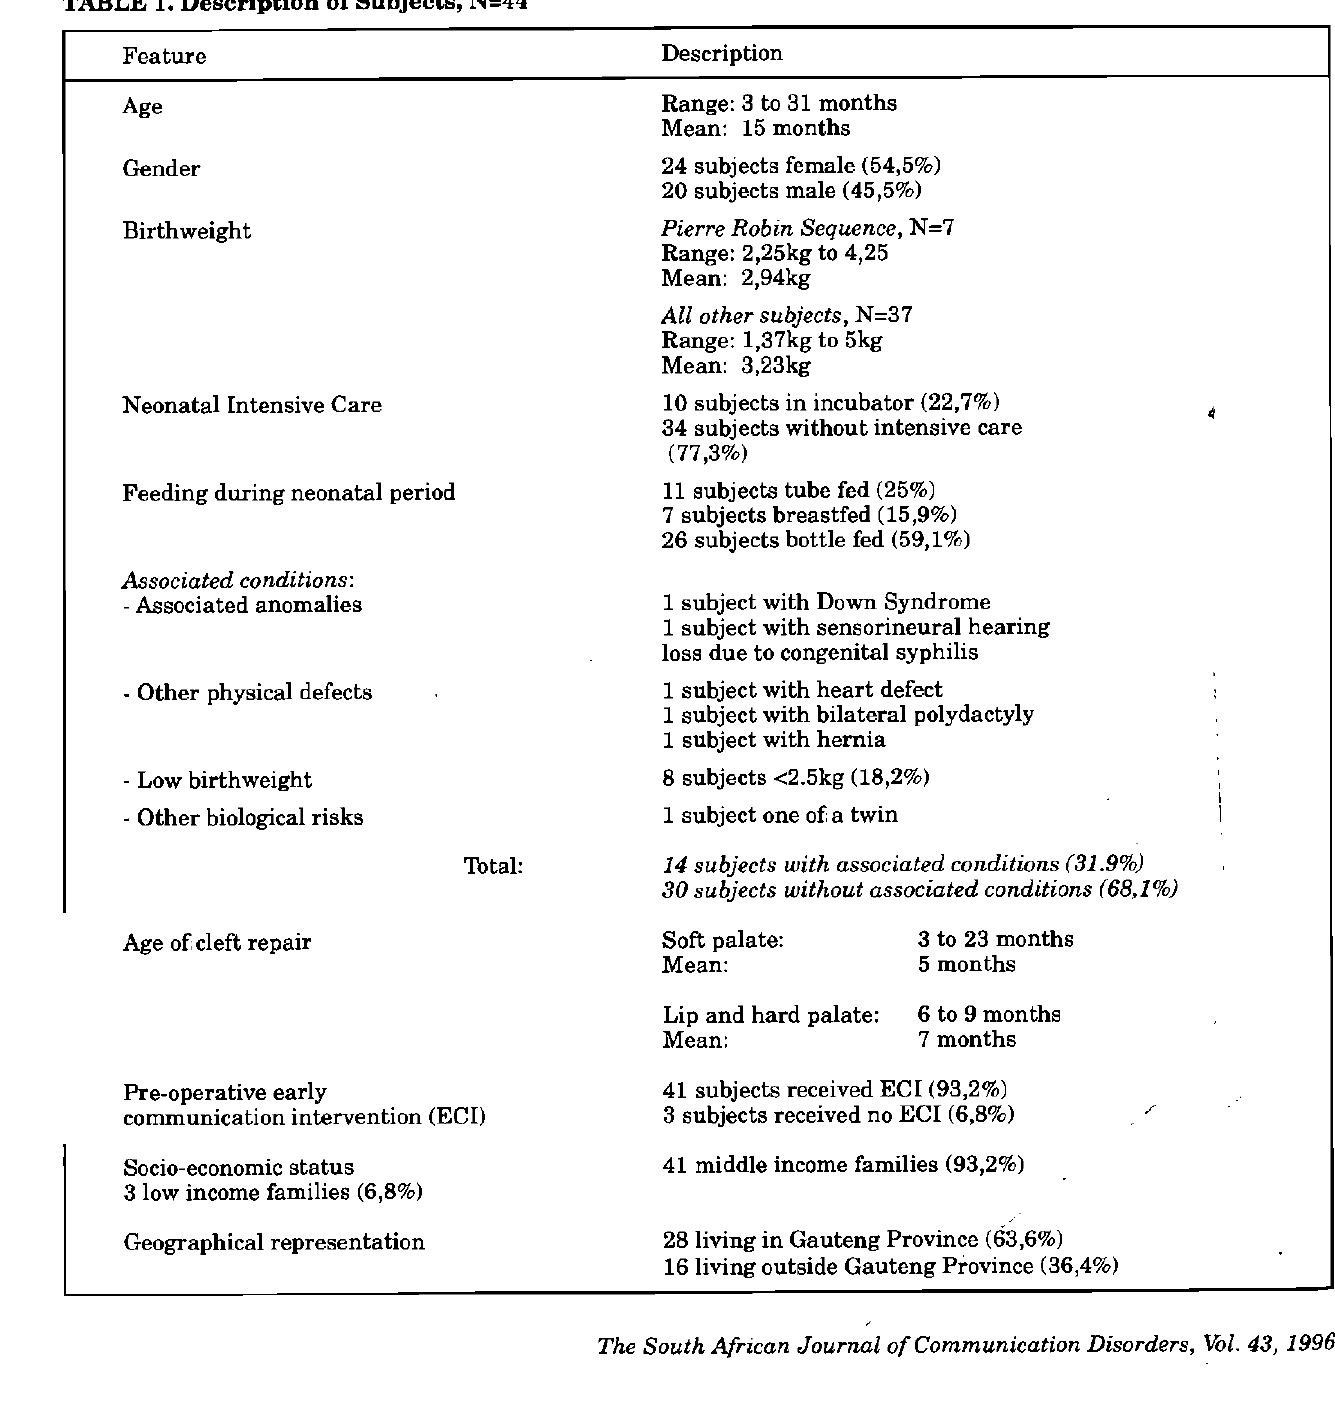
FIGURE 1: Differences in cleft types,